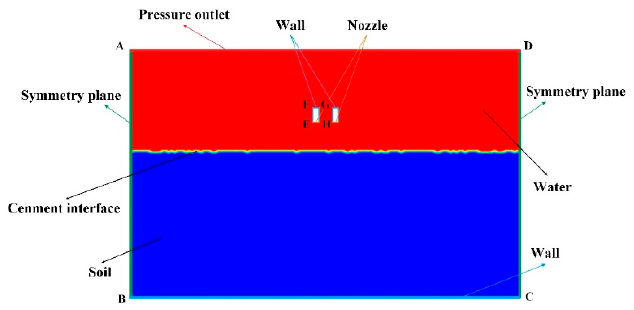
Figure 5. The dual-nozzle numerical simulation model.